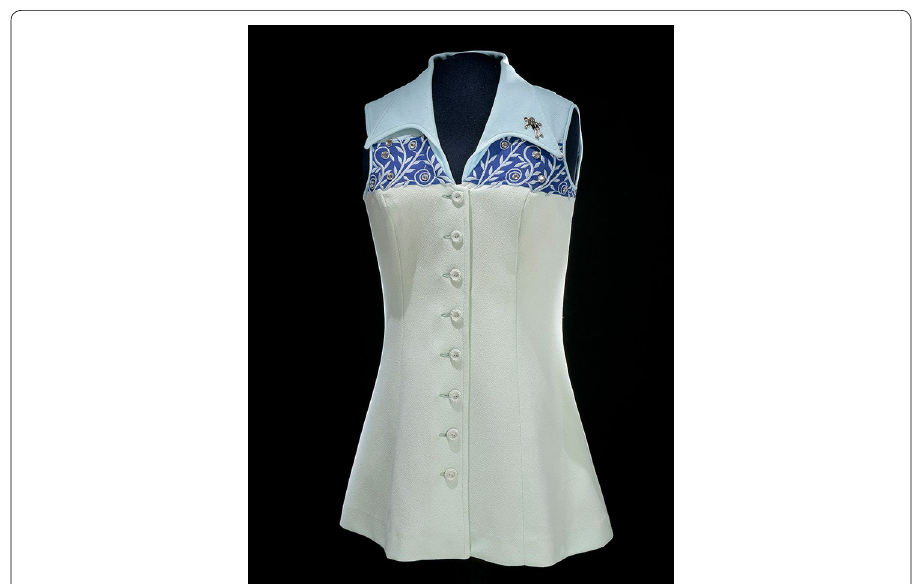
Fig. 4 Billie Jean King’s dress by Ted Tinling 1973. The National Museum of American